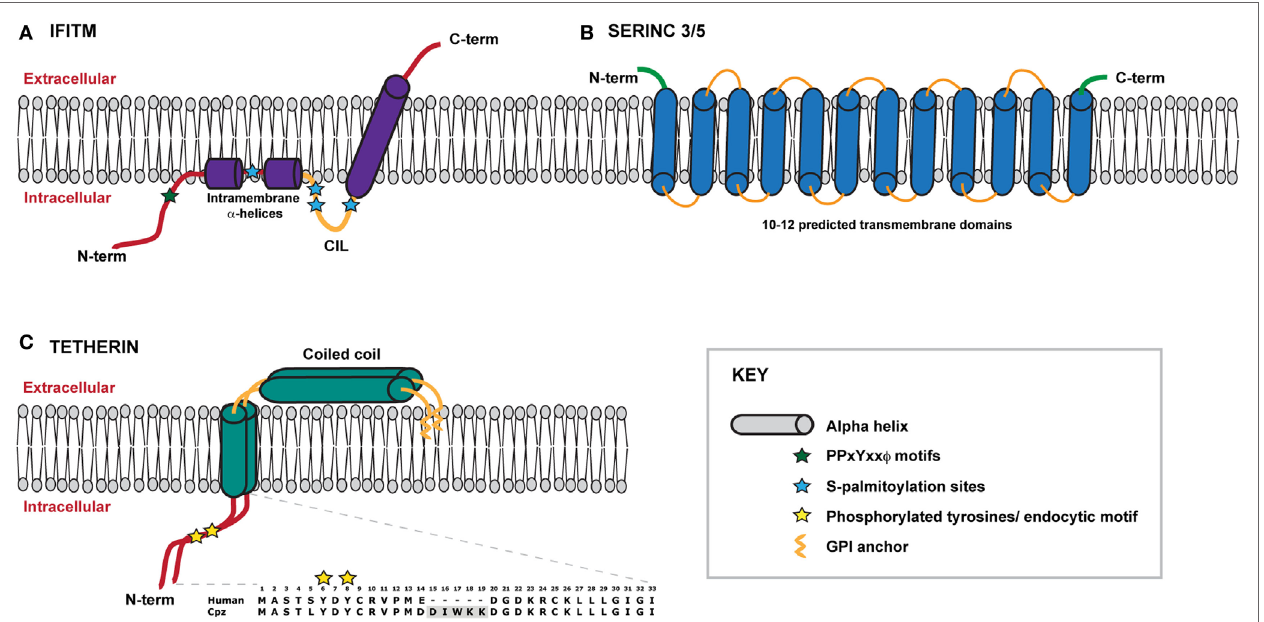
FigURe 1 | Schematic representation of IFITMS, SERINC 3/5 and tetherin within a model membrane. (A) A model of the IFITM protein, which adopts a type II transmembrane protein topology in the membrane. The N-terminal domain lies within the cytoplasm and connects to two short intramembrane α -helices. IFITMs 2 and 3 possess a longer N-terminal domain that contains important trafficking motifs that determine protein localisation. The conserved intracellular loop (CIL) contains sites of palmitoylation that likely stabilise the conformation of the C-terminal transmembrane α -helix which spans the membrane, thus positioning the C-terminal domain within the extracellular space. (B) Very little information about the structures of SERINC proteins is currently known. SERINCs 3 and 5 are thought to possess between 10 and 12 transmembrane helices such that the N- and C-termini reside within the extracellular space. (C) Tetherin exists as a dimer anchored to the membrane via an N-terminal transmembrane domain and a C-terminal GPI anchor. The extracellular portion of tetherin is comprised of a coiled coil. The N terminal cytoplasmic tail contains a dual tyrosine motif that plays a role in both steady-state cycling of the protein and signal transduction following virus retention. Amino acid sequences of human and chimpanzee cytoplasmic tails are shown for comparison, highlighting the deletion of the DIWKK motif. The short isoform of human tetherin lacks the first 12 amino acids of the cytoplasmic